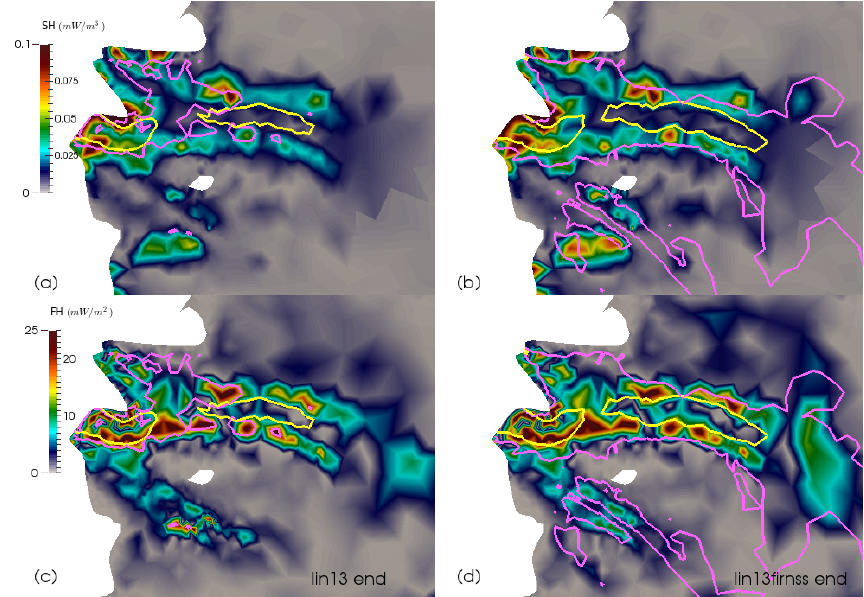
Figure 13. Close-up over Franklinbreen. Distribution of the mechanical heat sources at the end of the prognostic simulation. The upper line shows strain heat, the lower friction heat. Results of the simulation without firn heating ( lin13 ) are shown in (a) and (c) , the distributions are identical to those of 2008ss . Results with firn heating ( lin13firnss ) are shown in (b) and (d) . In pink the contour of 271K and in yellow the iso-velocity line of 150myr − 1 is